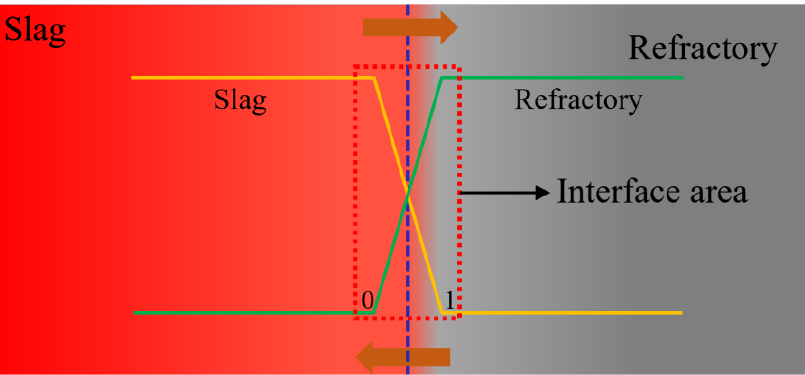
Figure 1. Thermodynamic calculation mechanism of the corrosion process.